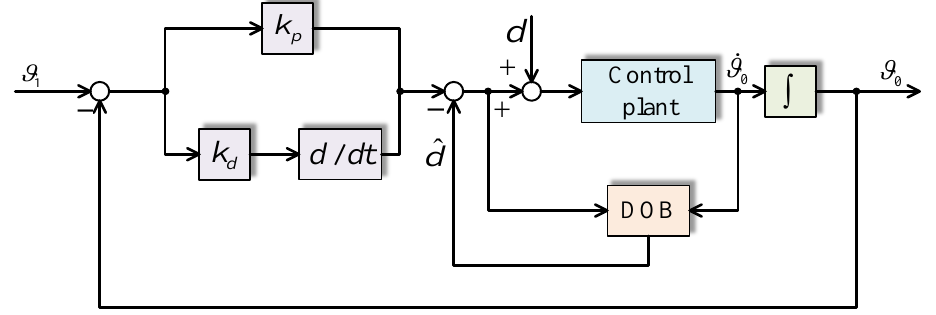
Figure 5. Control system diagram.